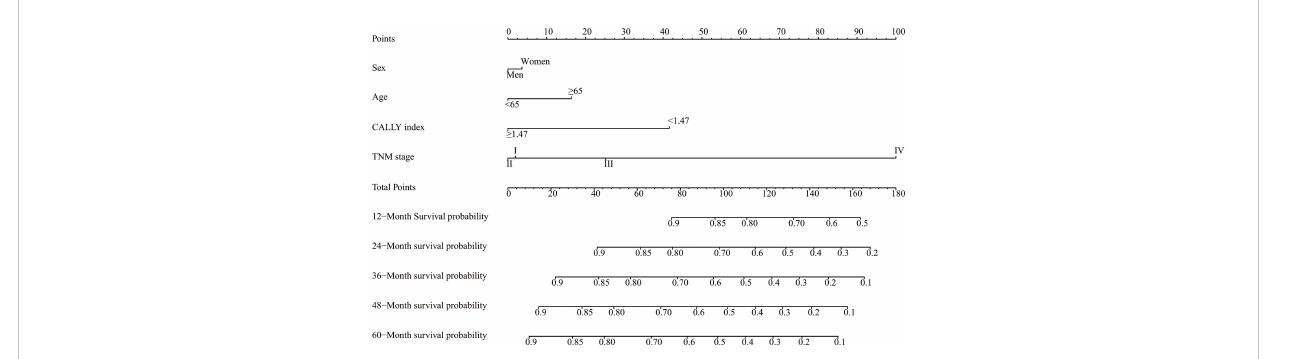
FIGURE 4 A proposed nomogram for predicting median survival time and survival probability in patients with CRC. Sex, age, the CALLY index and TNM stage were included in the constructed nomogram. To use the nomogram, a line is drawn upward to the Points axis to determine the number of points received for each variable. Sum of these points makes the total points. For total points, a line is drawn from the Total Points axis downward to the survival axes to determine the estimated median survival time and survival probability. CRC, colorectal cancer; CALLY, C-reactive protein-albumin-